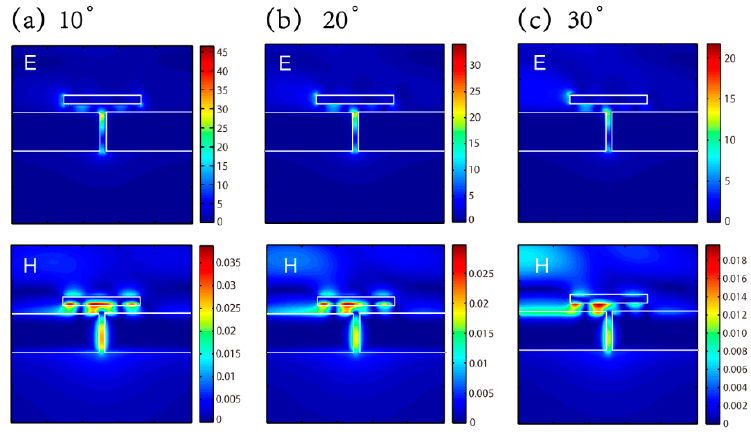
◦ ◦ ◦ , ( b )20 and( c )30 forTMpolarization.